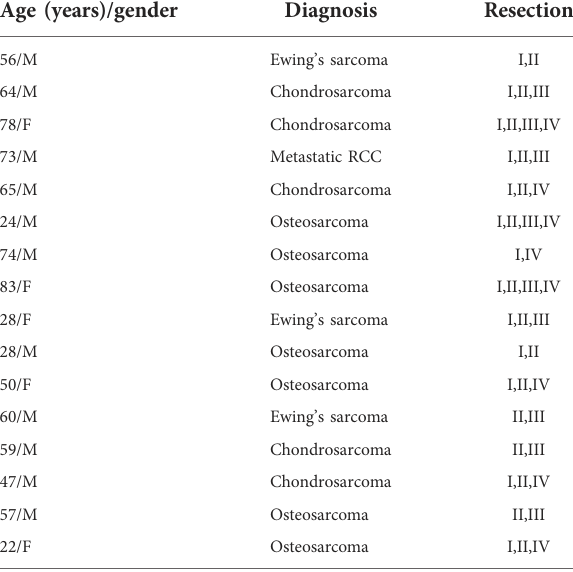
TABLE 1 Diagnosis on admission and tumor classi fi cation based on grade and stage.